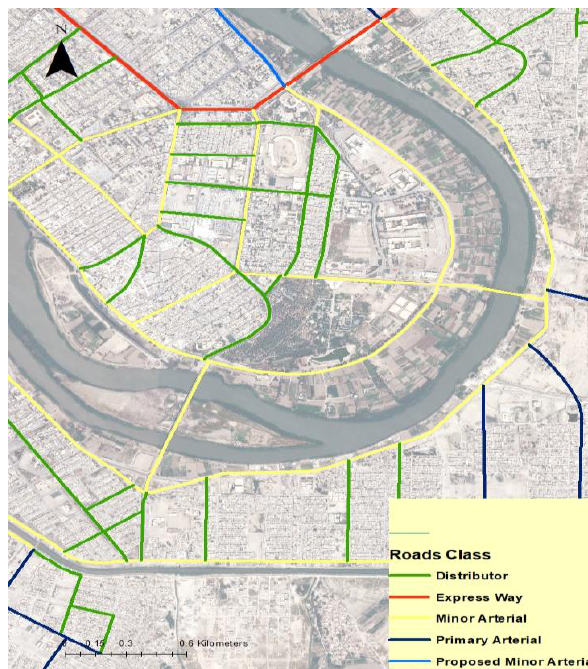
Fig. 6. The road hierarchy in the study area